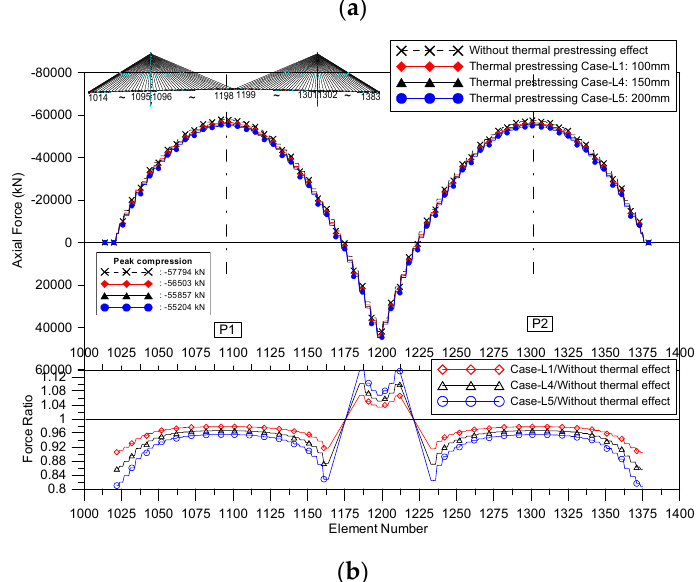
Figure 13. Axial girder forces for various elongation lengths. ( a ) Axial forces generated by heating and heat removal processes; ( b ) Axial forces after completed construction.